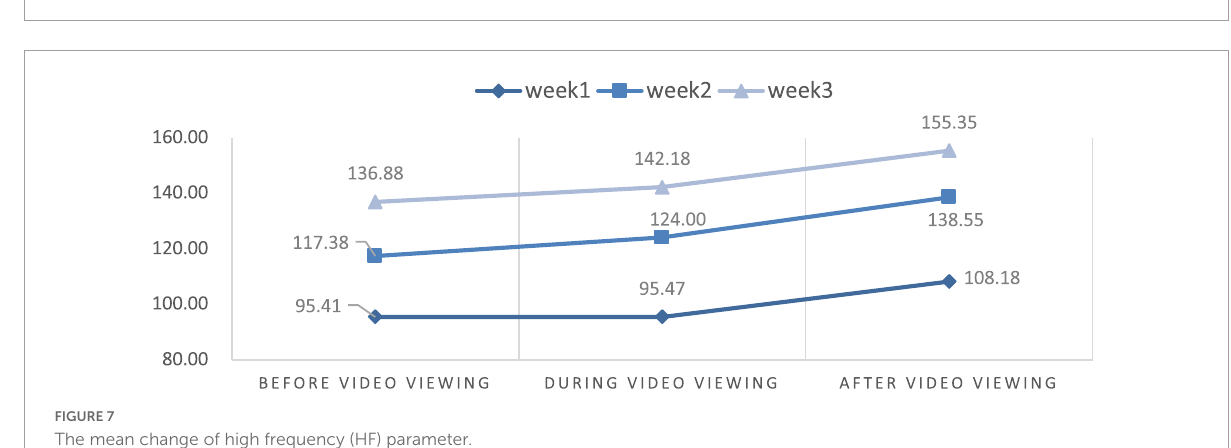
FIGURE6 The mean change of heart rate (HR) parameter.